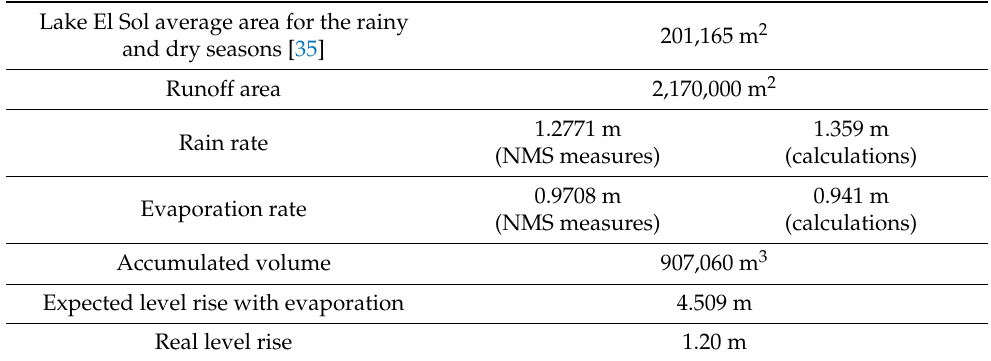
Table 3. Annual average values (with CNA